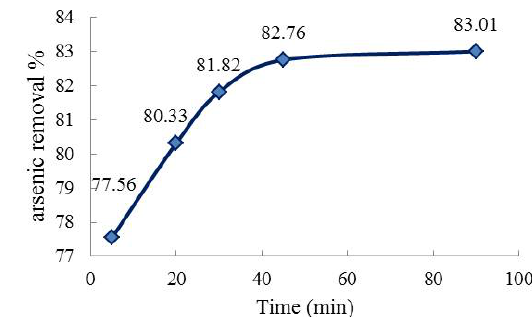
Fig. 8. The effect of β-CD-modified Fe O nanoparticle adsorbent Fig. 8 The effect of β -CD-modified Fe 3 O 4 nanoparticle adsorbent dosage on 3 4 Fig. 10. The effect of contact time on the arsenic removal dosage on arsenic efficiencies and adsorption capacity Fig. 10 The effect of contact time on the arsenic removal efficiency by the β -CD efficiency by the β-CD modified Fe O nanoparticle. The arsenic efficiencies and adsorption capacity. 3 4 initial concentration of arsenic was 50 ppm here modified Fe 3 O 4 nanoparticle. The initial concentration of arsenic was 50 ppm here.